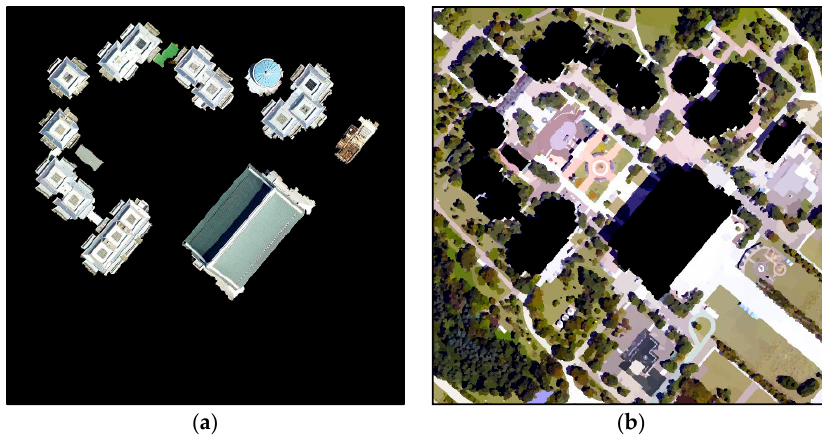
Figure 4. Results of output-level fusion: ( a ) building area and ( b ) non-building area.